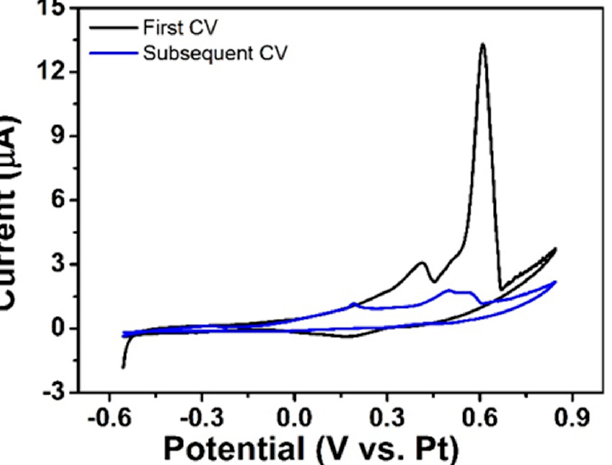
Figure 5. First and second CVs of Ventolin TM formulation at NPG-modified microdisc array electrode recorded from − 0.55 to 0.85 V vs. Pt at 10 mV s − 1 .